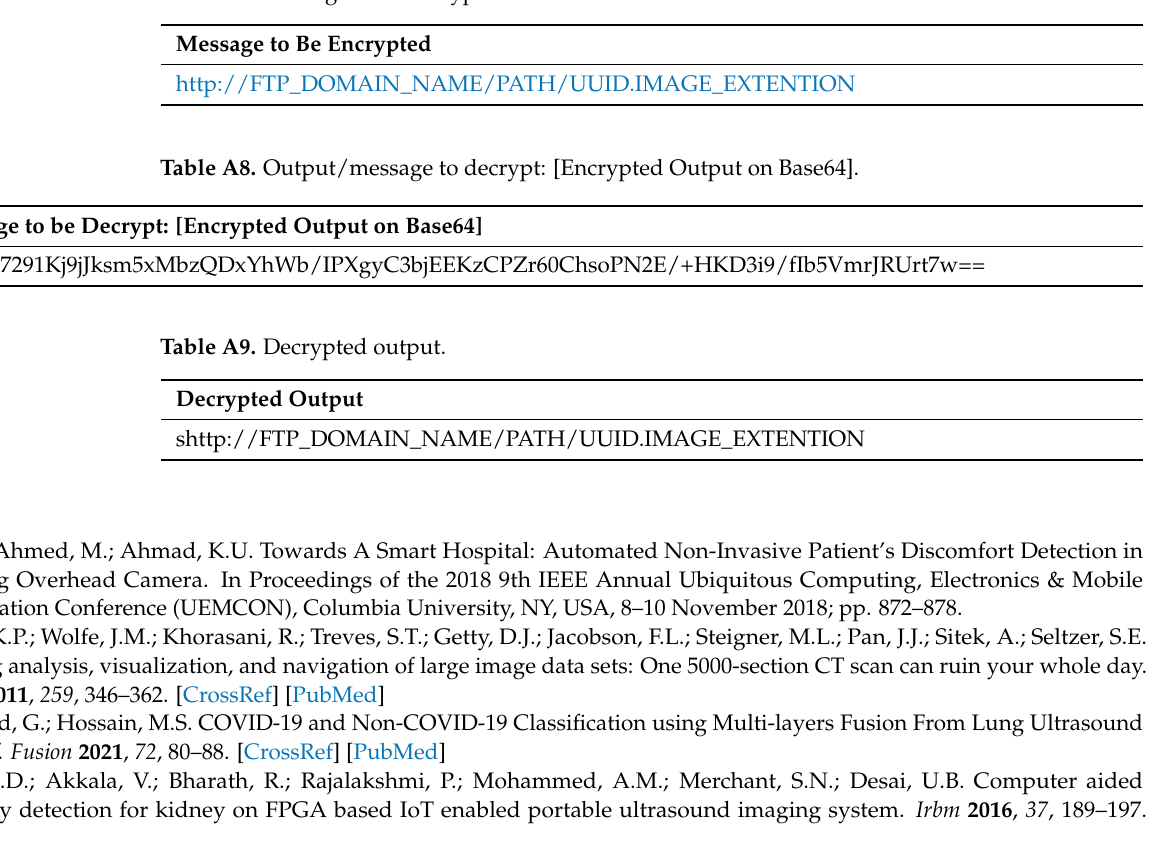
Table A7. Message to be encrypted.